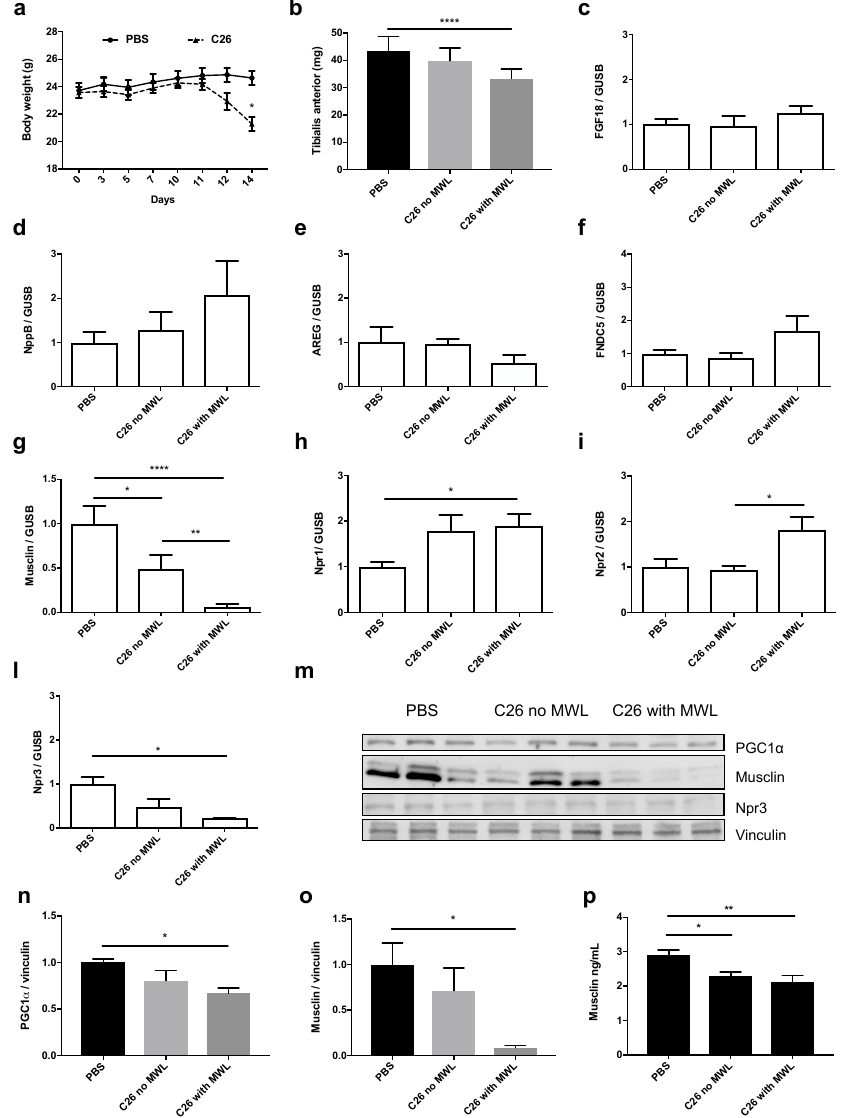
Figure 3. Only musclin is reduced in Tibialis Anterior (TA) and plasma of C26-bearing mice even at times when muscles and body weights have not yet been reduced. The body weights of the